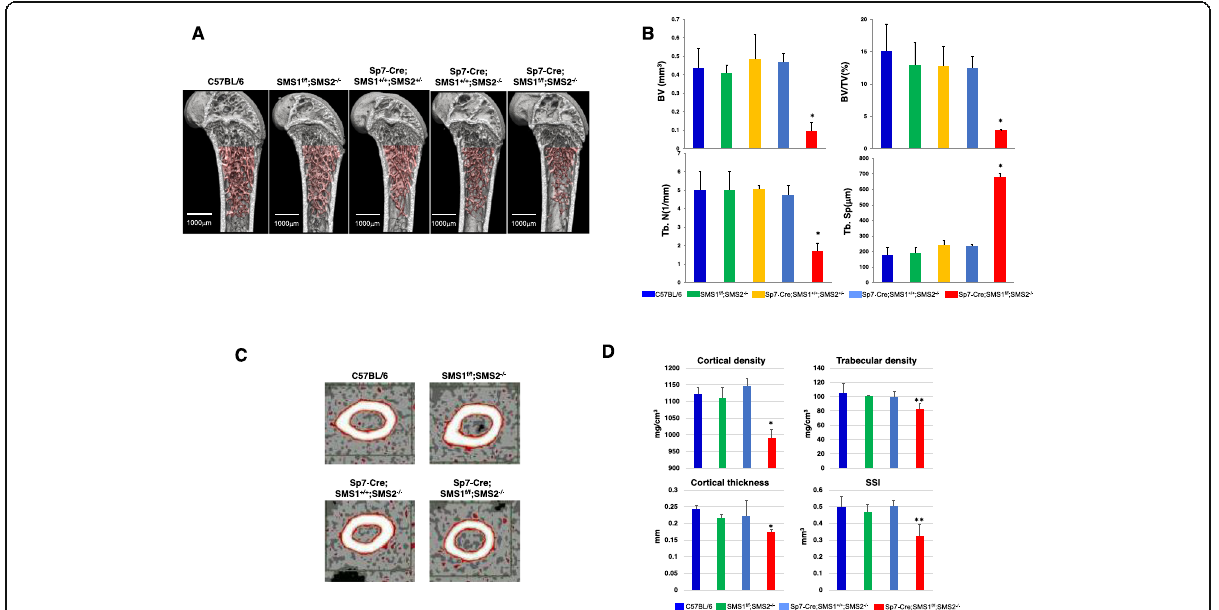
Fig. 2 Note the osteoporotic phenotype of the Sp7-Cre;SMS1 f/f ;SMS2 − / − mice. a Representative micro-CT images of the distal femoral shafts of 15- week-old C57BL/6, SMS1 f/f ;SMS2 − / − , Sp7-Cre;SMS1 +/+ ;SMS2 +/ − , Sp7-Cre;SMS1 +/+ ;SMS2 − / − and Sp7-Cre;SMS1 f/f ;SMS2 − / − mice. 3D reconstruction of trabecular bone. b Micro-CT analysis of femurs from 15-week-old mice. Abbreviations: BV, bone volume; BV/TV, bone volume/total volume; Tb N, trabecular number; Tb Sp, trabecular separation; * p < 0.05 versus C57BL/6, SMS1 f/f ;SMS2 − / − , Sp7-Cre;SMS1 +/+ ;SMS2 +/ − and Sp7-Cre;SMS1 +/+ ;SMS2 − / − ; mean ± SD, n = 10 for each genotype. c Isolated femurs of 15-week-old mice were scanned using pQCT. Sections were made at the midshaft. d Quantification of cortical density, trabecular density, cortical thickness and strength strain index (SSI). * p < 0.005 versus C57BL/6, SMS1 f/f ;SMS2 − / − , and Sp7-Cre;SMS1 +/+ ;SMS2 − / − , **p < 0.05 versus C57BL/6, SMS1 f/f ;SMS2 − / − and Sp7-Cre;SMS1 +/+ ;SMS2 − / − ; mean ± SD, n = 8 – 10 for each